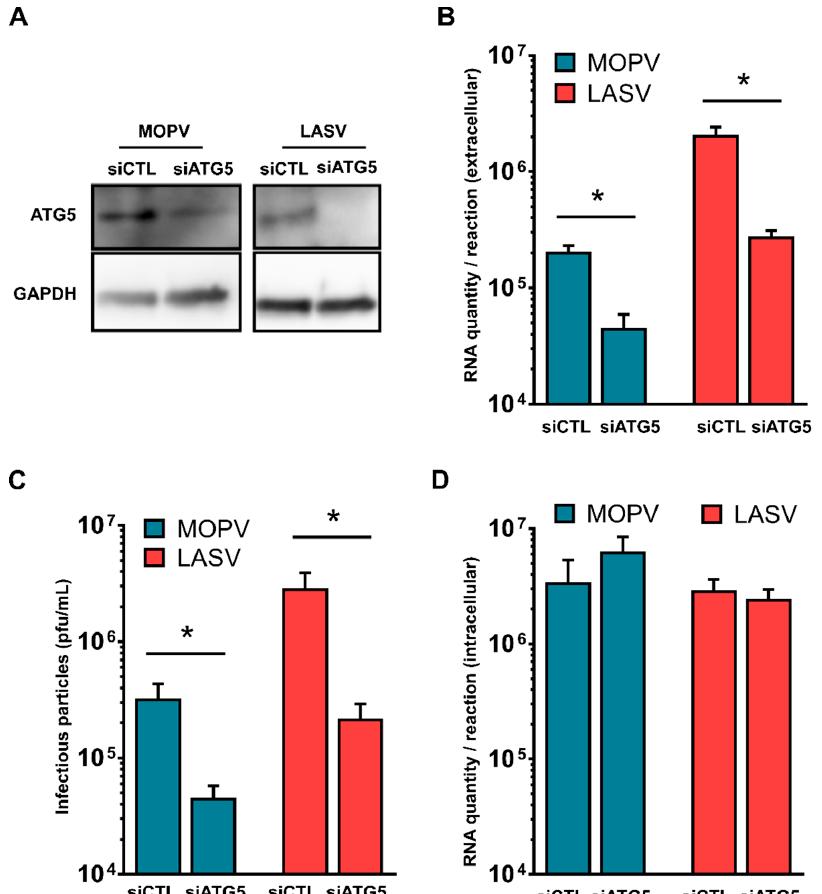
Figure 4. Non-degradative steps of autophagy increase both LASV and MOPV infectious particle production. ( A ) HeLa cells were transfected with the indicated siRNA for 72 h before analysis of silencing efficiency by Western blotting ( n = 4 independent experiments); ( B – D ) the same cells as in (A) were then infected with LASV or MOPV at an MOI of 0.1 for 1 h before being maintained for three days at 37 ◦ C. Viral RNA was then extracted from the cells and supernatants for quantification by RTqPCR. The infectious particles from supernatants were also titrated on Vero cells. The error bars represent the standard error of the means from four independent experiments. * indicates p < 0.05, as determined by the Mann–Whitney